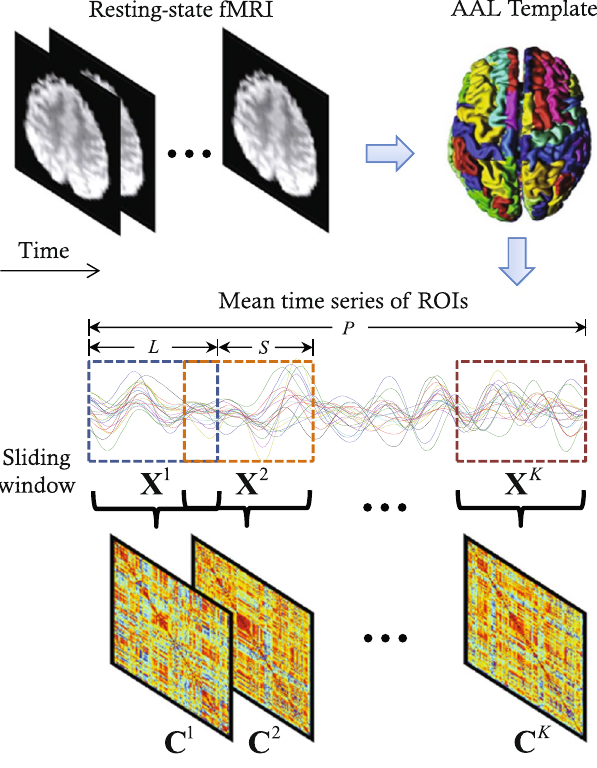
Figure 8. Illustration of the construction of dynamic low-order FC networks using sliding window-based Pearson’s correlation on rs-fMRI